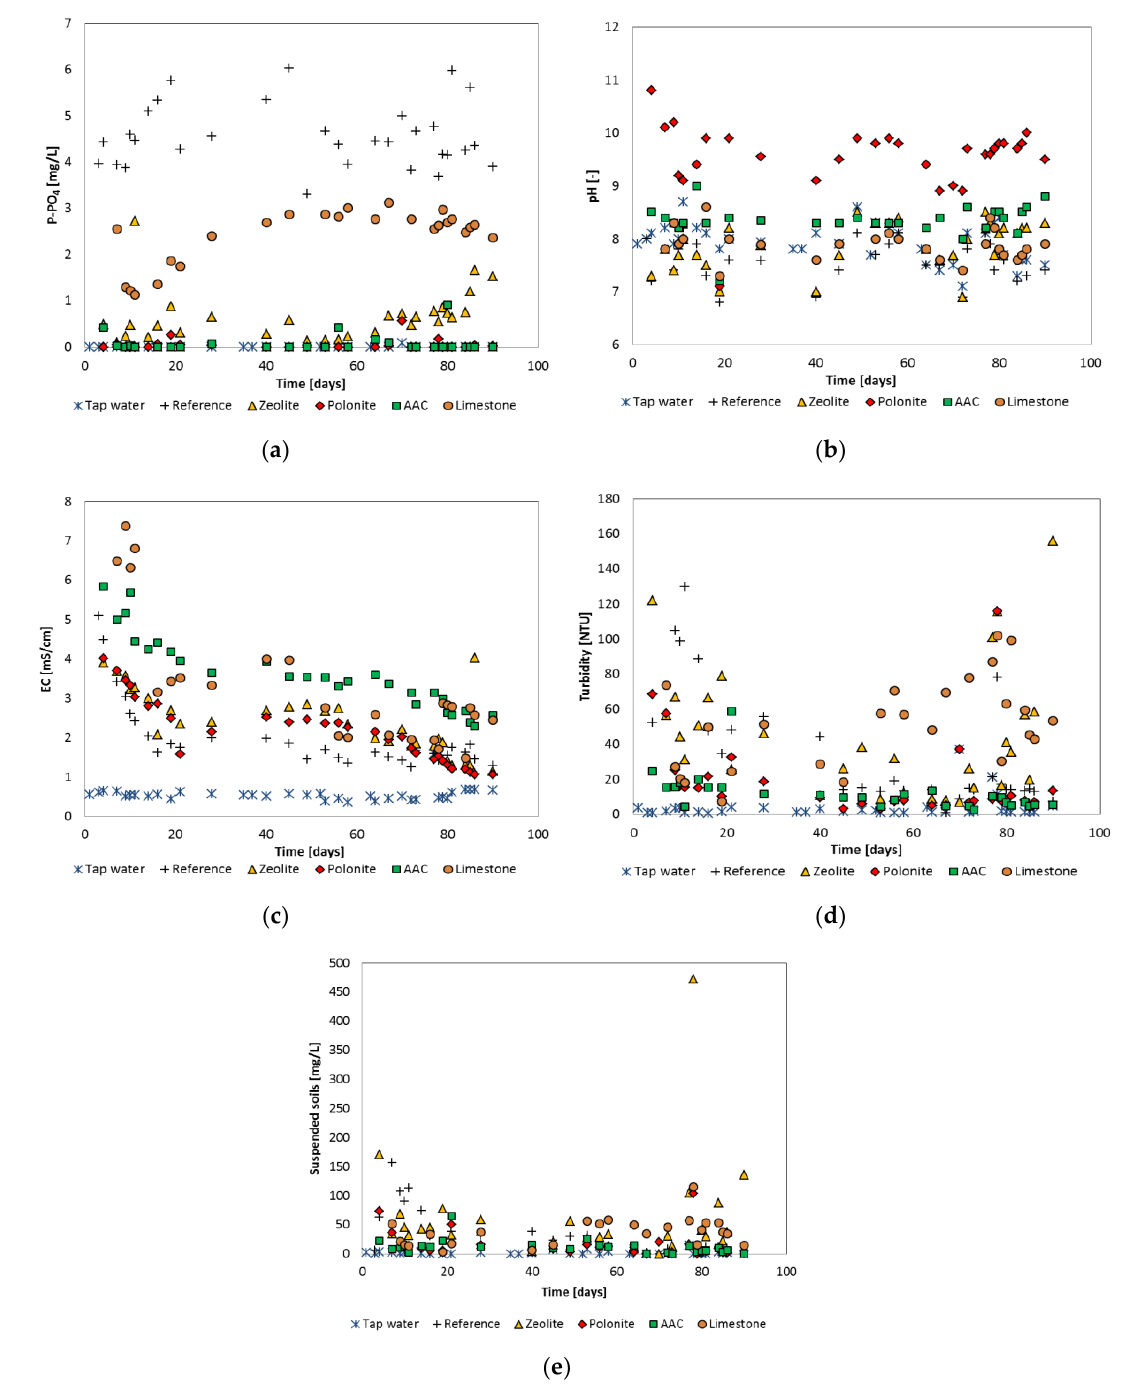
Figure 3. The P-PO 4 ( a ); pH ( b ); electrical conductivity (EC) ( c ); turbidity ( d ) and suspended solids ( e ) changes of simulated precipitation (tap water), leakages from the reference and PRBs columns over the duration of the